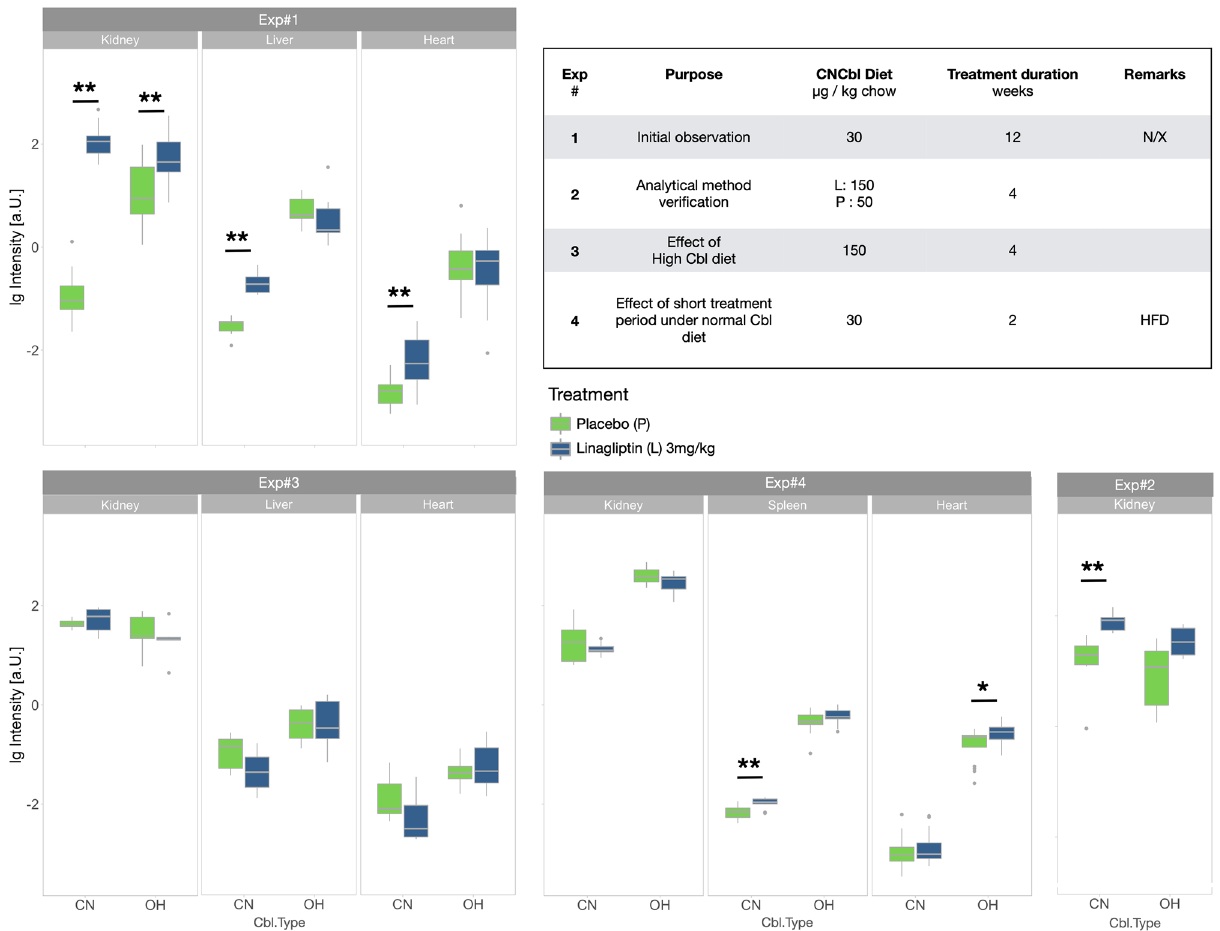
Figure 1. MS detection of CN and OH cobalamin in different organs from 4 independent mice studies. Box- and-whisker of log OHCbl and CNCbl standardized intensities obtained from experiments listed in Table 1. The inset shows the basic experimental parameters. The number of data points are for Exp#1:88; Exp#2: 12; Exp#3: 36; Exp#4: 96. **Significant differences between linagliptin treatment and placebo. CNCbl, cyanocobalamin; OHCbl, Hydroxycobalamin, lg, natural logarithm; HFD, high fat diet; N/X, 5/6 nephrectomy.